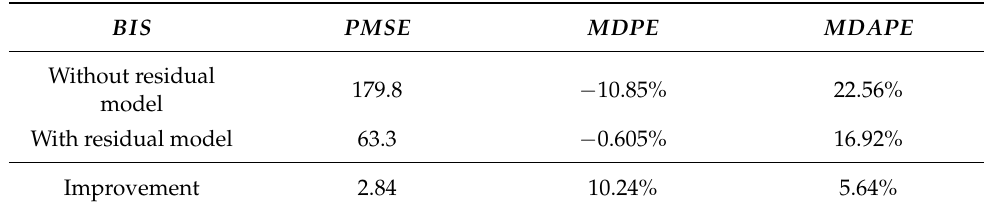
Table 4. Predictive quality measures for BIS